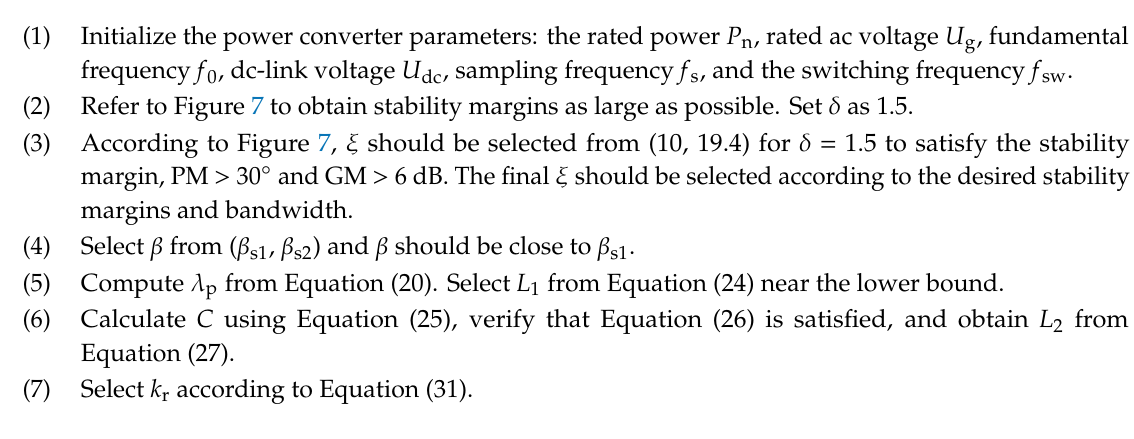
Table 1. summarizes the parameter constraints and design guideline of the integrated design method. Procedure of the design is presented below. method. Procedure of the design is presented